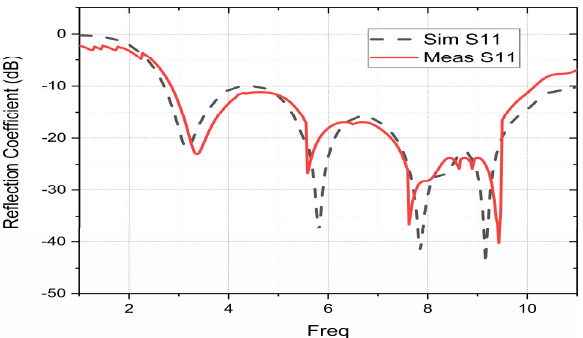
Figure 9. Comparison of measured and simulated results of the proposed fractal patch.